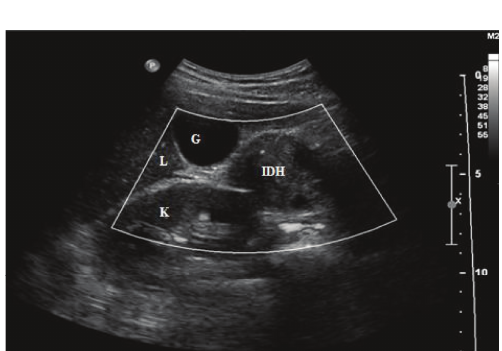
Figure 1: Ultrasound of the abdomen demonstrates a well-defined heterogenous 3 . 5 × 3cm lesion anterior to the right kidney in the location of second part of duodenum. IDH: intramural duodenal hematoma; L: liver; G: gall bladder; K: kidney.